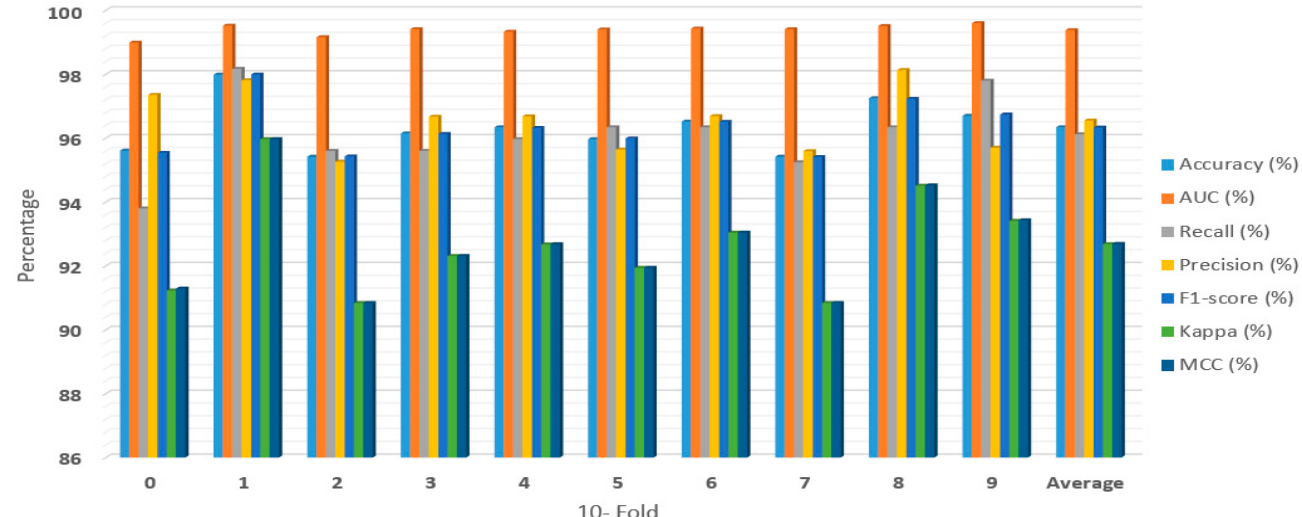
Figure 9. The metrics of the RXLM model after tuning the hyper-parameters.